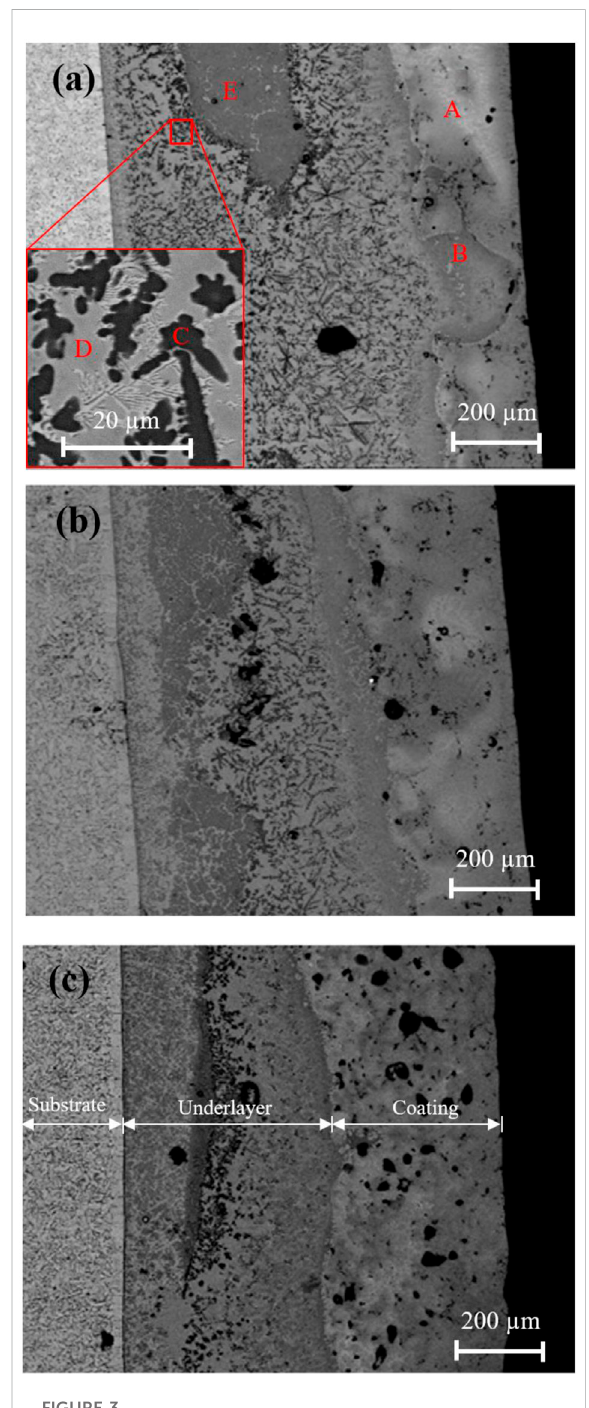
FIGURE 3 Back scattered SEM micrograph of synthesized by heating rates of (A) 46.6 K/s, (B) 57.0 K/s, and (C) 85.5